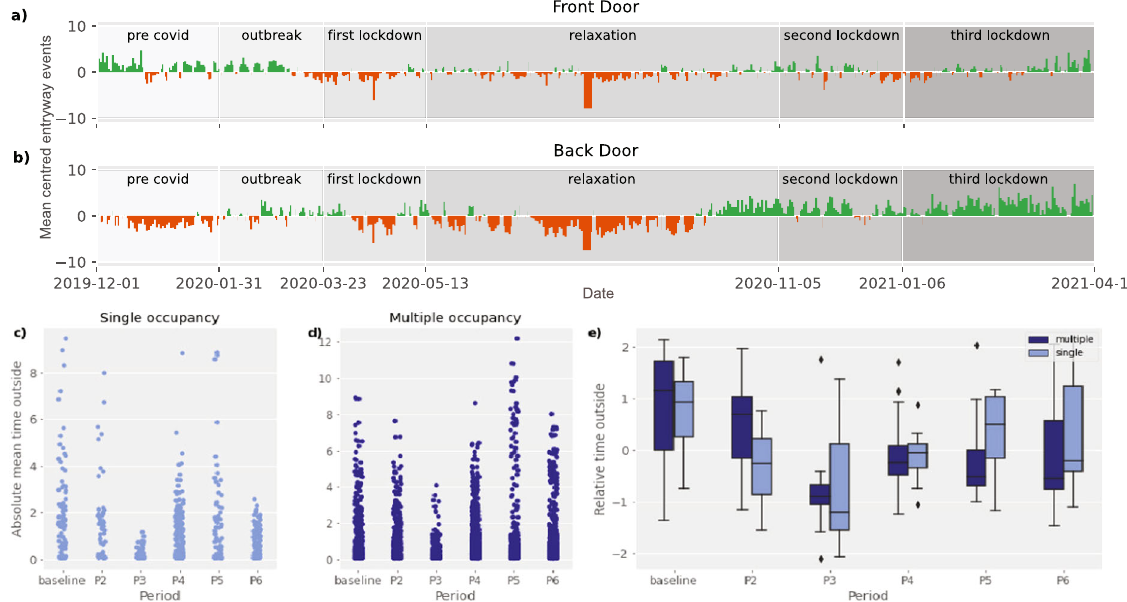
Fig. 4 Changes in entryway events and time spent outside during COVID-19. a , b Mean-centred daily mean entryway events across the different periods for the front and back door; c , d Raw total daily time spent outside for single and multiple occupancy households for the six pandemic periods; e Standardised mean time spent outside across households during the different periods identi fi ed (boxplot shows the minima and maxima values, lower and upper quartiles, and the